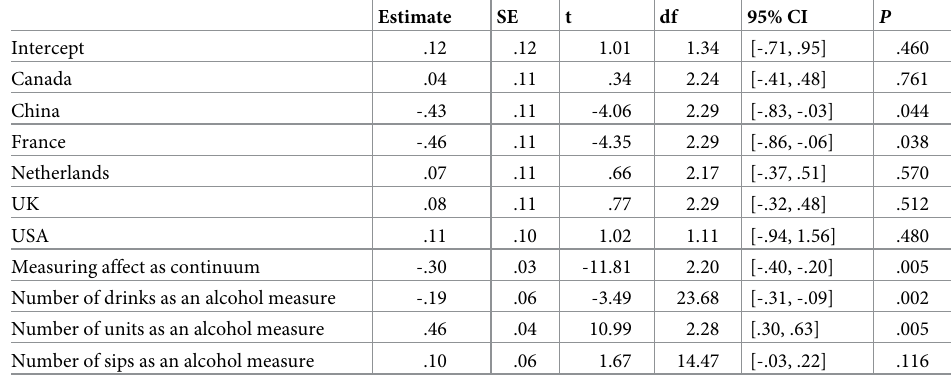
Table 2. Moderators of the relationship between negative affect and alcohol consumption